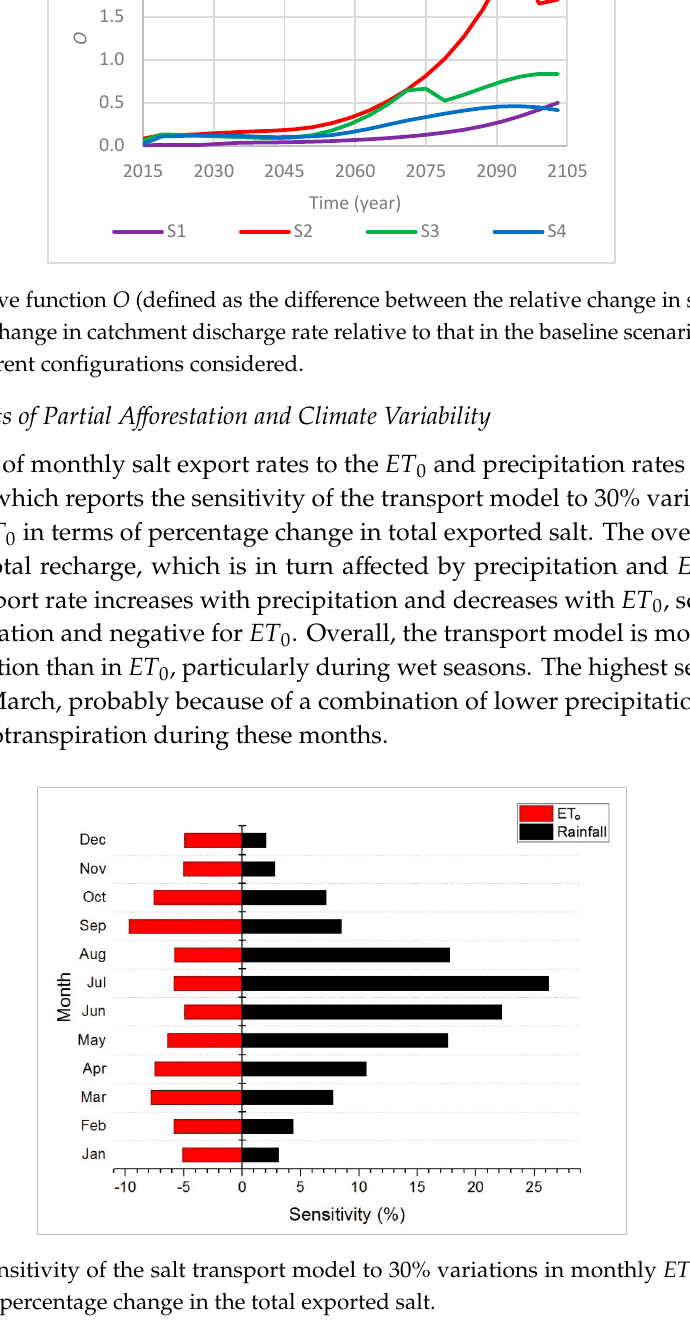
Table 5. Ranking of monthly precipitation and ET based on the sensitivity indices.